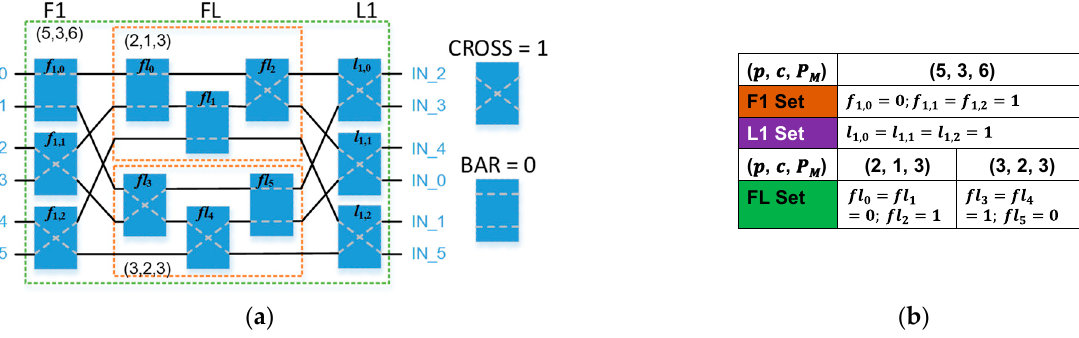
Figure 26. ( a ) Six-input switching network architecture and ( b ) its control signal table for ( p , c, P M ) = (5, 3, 6).